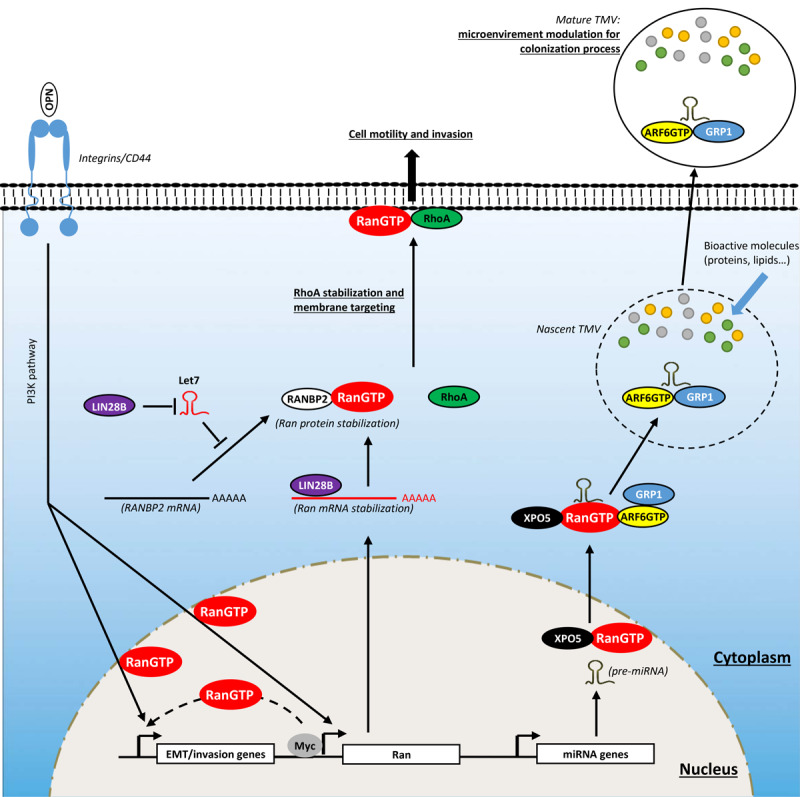
Involvement of Ran in activating invasion and metastasis. Ran, through direct and indirect interactions with oncogenes, is involved in cell invasion. Myc, which is overexpressed in several cancers, interacts directly with the promoter of Ran and induces its expression. The LIN28B oncogene stimulates the expression of Ran directly through the stabilization of its mRNA by direct interaction and indirectly the destabilization of Let7 which is known to destabilize Ran protein through RANBP2 degradation. The induction of Ran promotes cell invasion by different ways: (1) by inducing epithelial-to-mesenchymal transition (EMT); (2) by mediating the invasive signals originating from osteopontin (OPN), Myc, and LIN28B; (3) by stabilizing and targeting RhoA to the plasma membrane; and (4) by delivering oncogenic cargo such as pre-miRNAs to nascent tumor-derived microvesicles (TMVs).